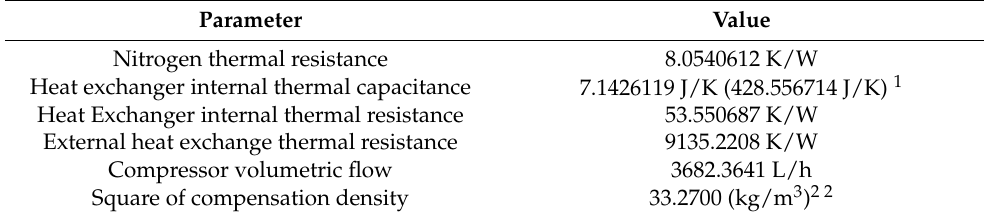
Table 2. Cryogenic cooler model parameters.